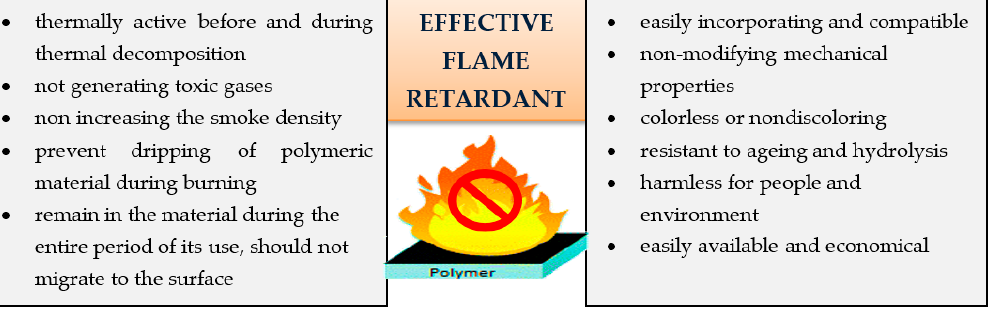
Figure 3. Quality properties of flame retardants [30].